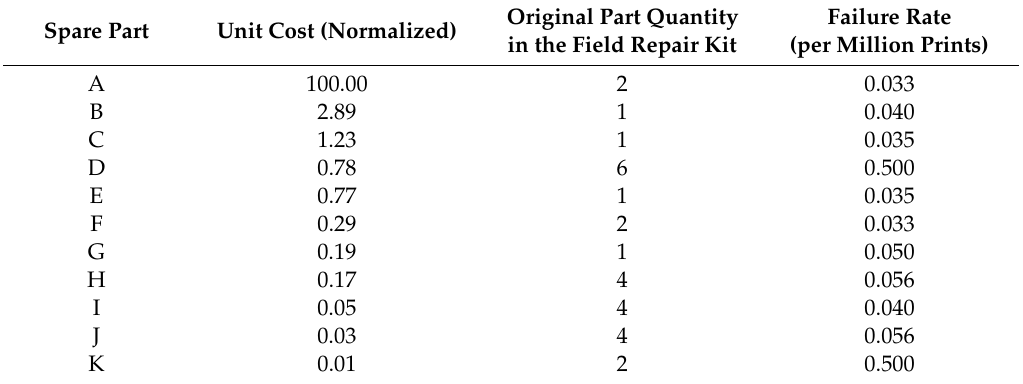
Table 3. Partial list of spare parts and quantities in the PSS field repair kit originally proposed by the design team.